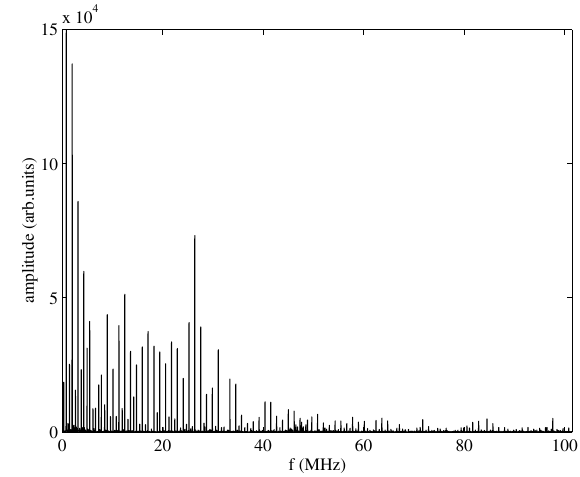
FIG. 10. Horizontal multibunch spectrum.